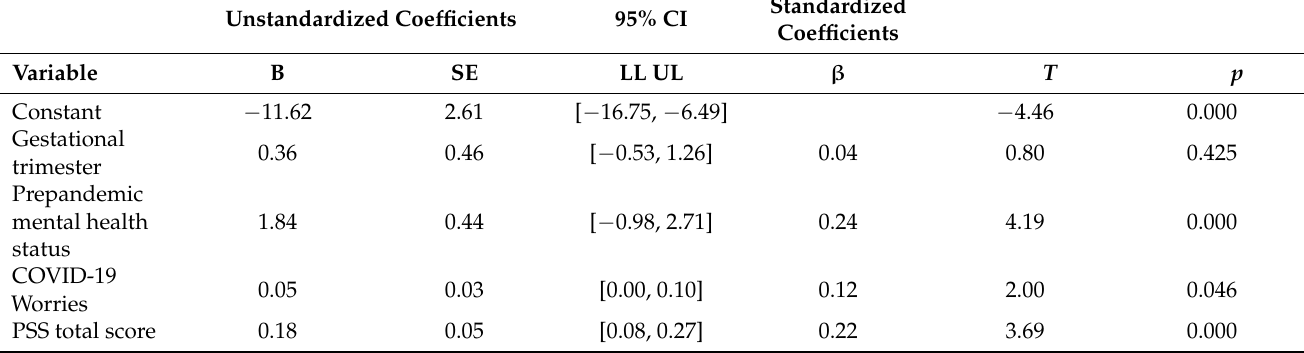
Table 5. Multiple linear regression model estimating the effect of PSS and COVID-19 worries on changes in mood symptoms ( N =